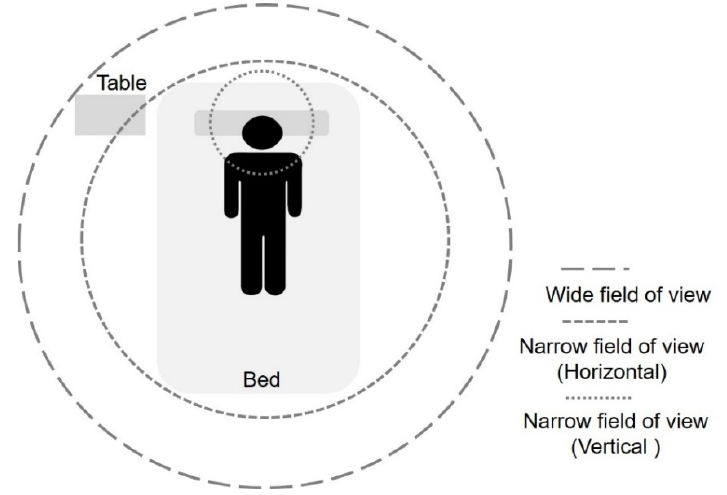
Figure 1. Object (human body) tracking